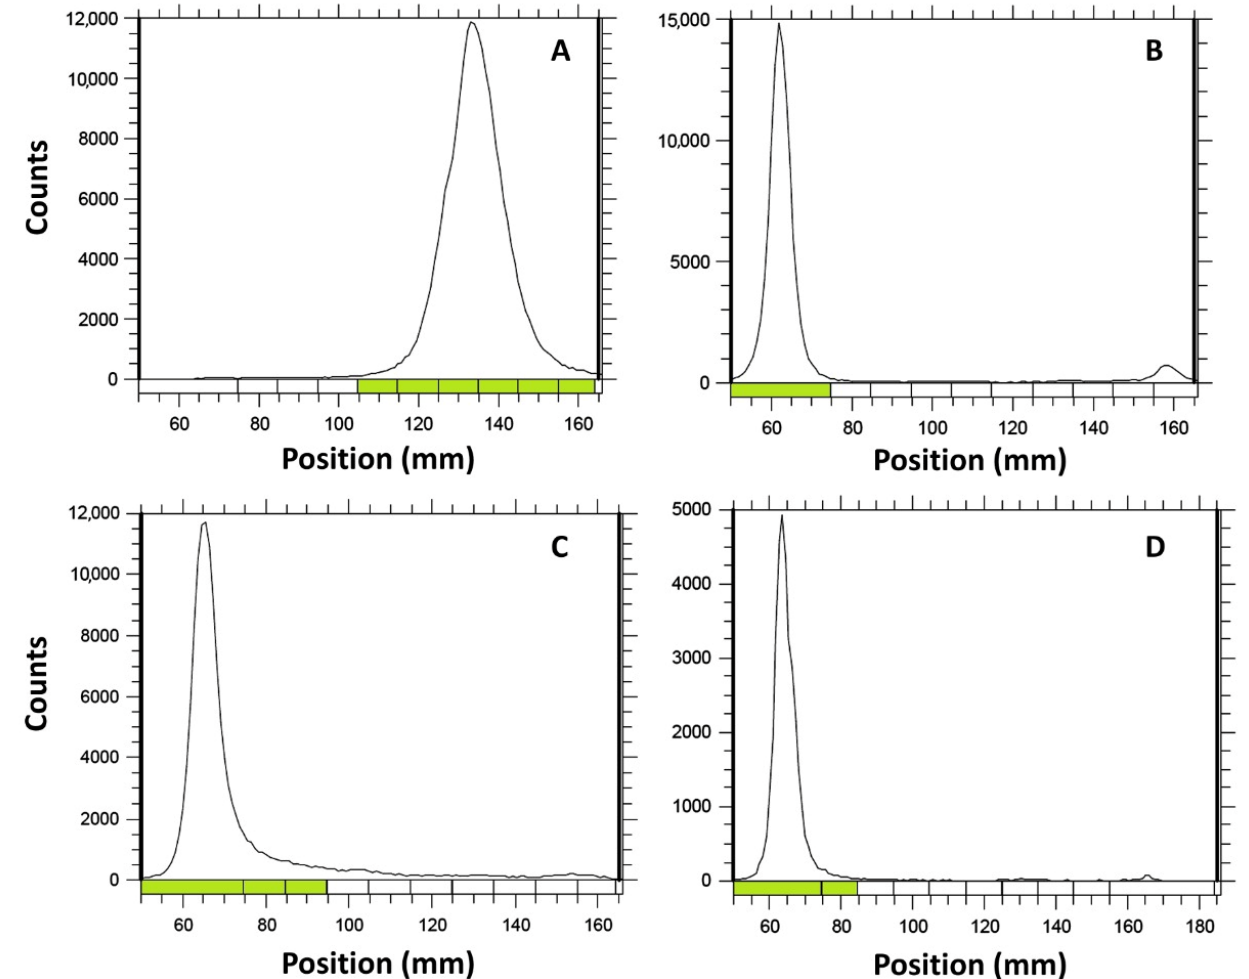
Figure 3. Radiochemical yield evaluated by thin layer chromatography (TLC): ( A ) [ 131 I]NaI; ( B ) [ 131 I]I-GRGDYV; ( C ) [ 99m Tc][Tc(CO) 3 ] + ; ( D ) [ 99m Tc]Tc(CO) 3 -GRGDHV.